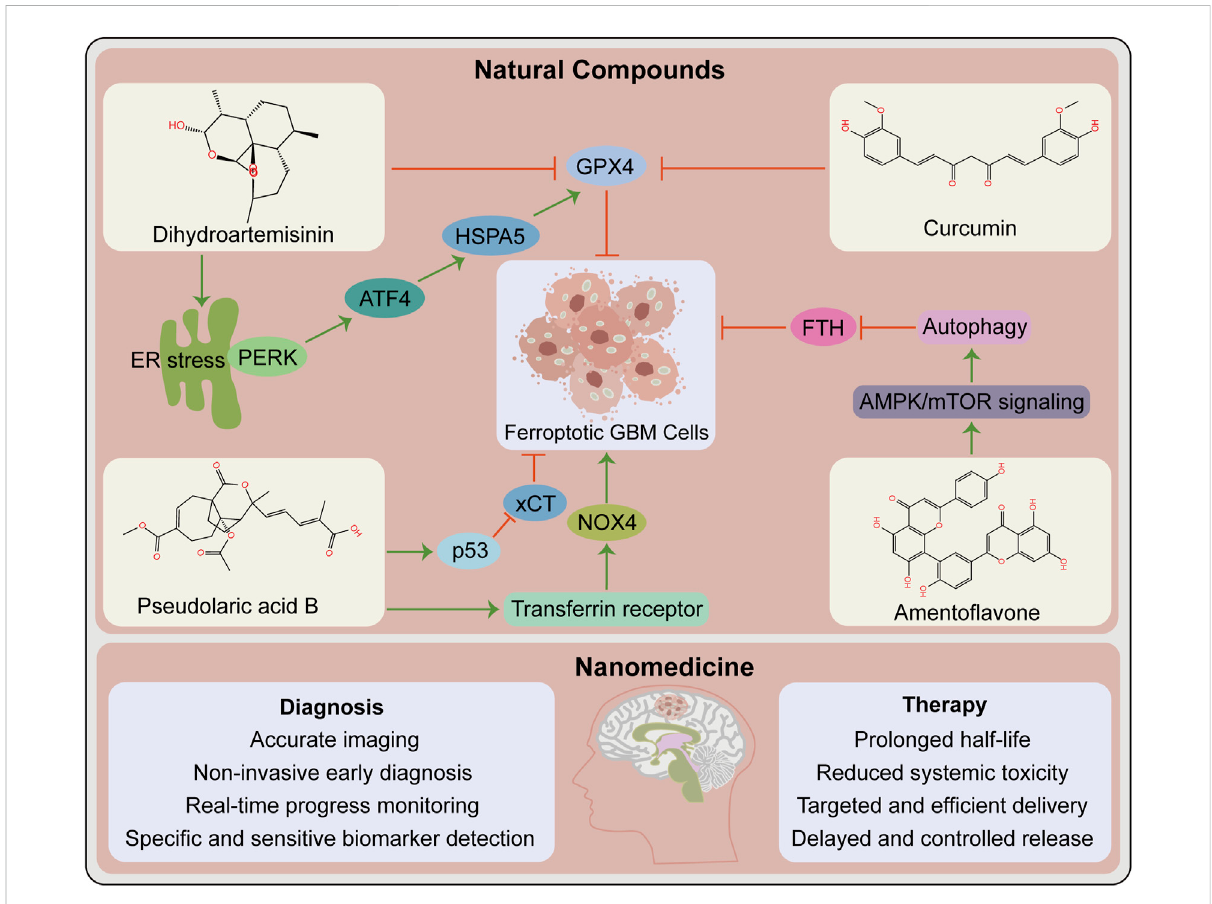
FIGURE 2 Opportunities for ferroptosis in glioblastoma therapy. Contribution of natural compounds to the treatment of glioblastoma such as dihydroartemisinin, curcumin, pseudolaric acid B and amento fl avone. The upper box shows the chemical structures of these four compounds and the associated mechanisms that regulate ferroptosis in glioblastoma. The below box lists the potential advantages of nanomedicine in the diagnosis and therapy of glioblastoma. ATF4, activating transcription factor 4; ER, endoplasmic reticulum; FTH, ferritin heavy chain. GPX4, glutathione peroxidase 4;HSPA5, heat shock protein family A (Hsp70) member 5; NOX4, NADPHoxidase 4;PERK, proteinkinase R-like ER kinase; xCT,SLC7A11, solute carrier family 7 member